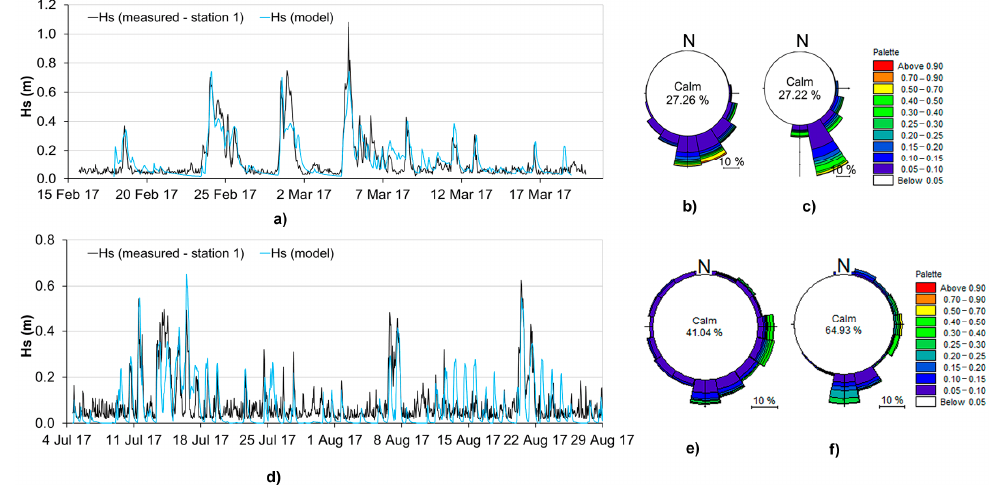
Figure 18. Relationship of measured and modelled ( a ) significant wave heights H S and ( b ) peak period T P against measured wind speed V wind , under the action of wind from SSE direction in the course of 12 h (recording obtained from measurement at wave rider site in front of the main breakwater in Rijeka Harbour). Rijeka Harbour).